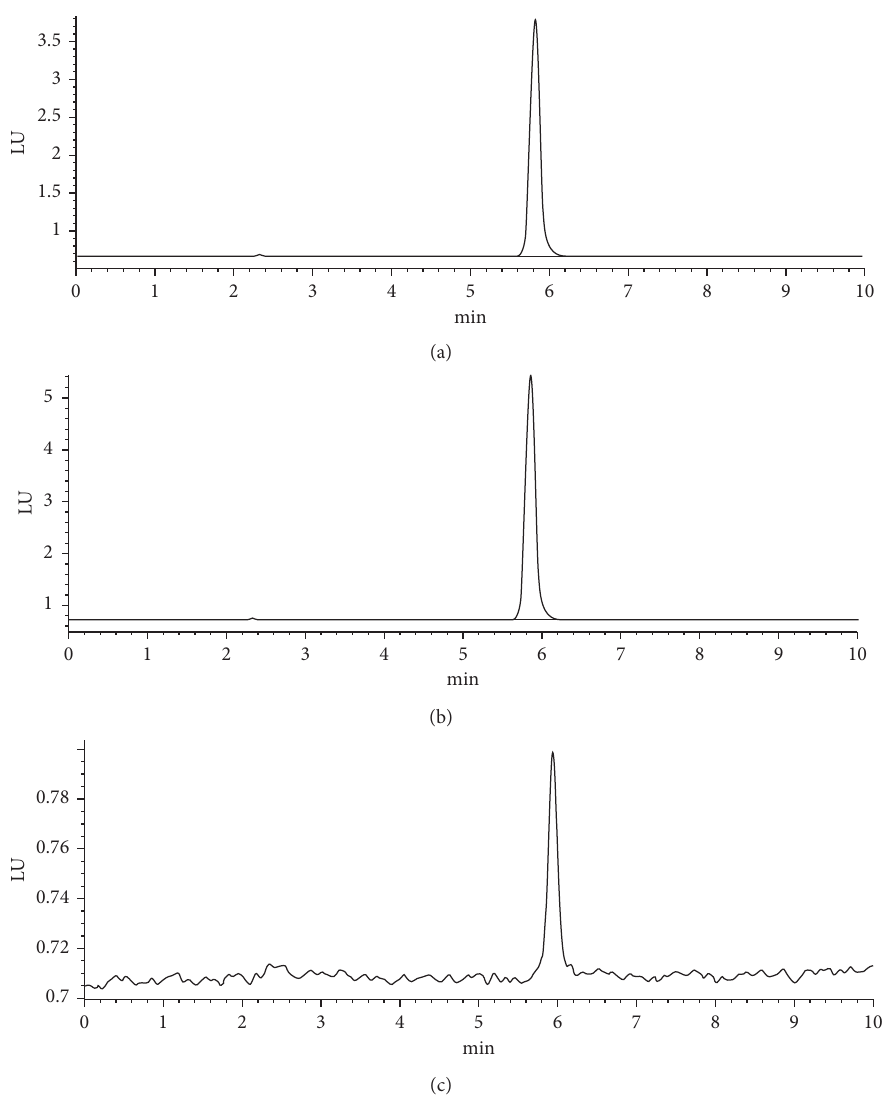
Figure 3: The typical chromatogram: (a) reference compounds of 4-methylumbelliferone, (b) product of 4-methylumbelliferone, and (c) product of 4-methylumbelliferone inhibited with baicalin or natural product extracts. Table 1: Intraday and interday accuracy and precision and stability of 4-methylumbelliferone ( n � 6). Compound